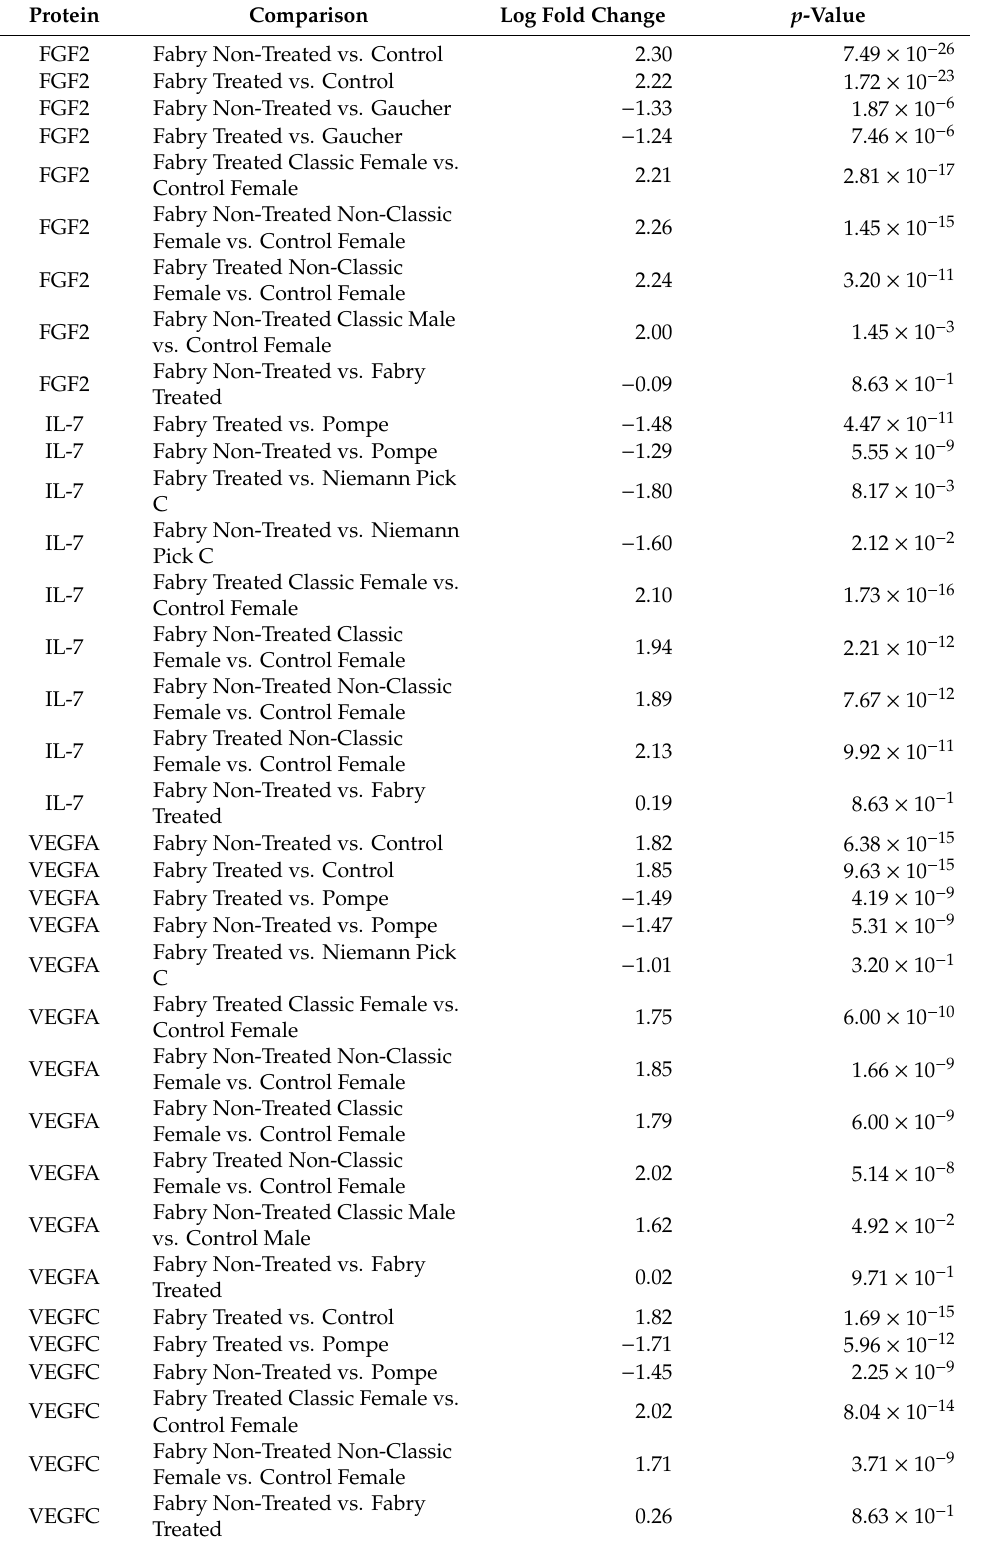
Table 2. Statistical metrics of the most di ff erentially expressed proteins. Protein Comparison Log Fold Change p -Value